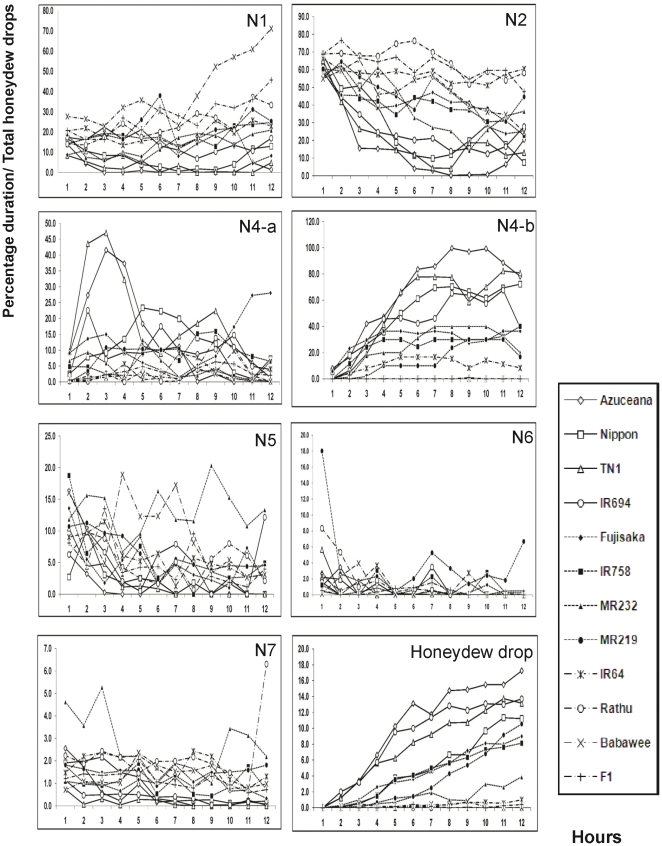
Comparative graph between EPG waveform and honeydew drops.This graphs are based on percentage duration for each waveform types, NP (Non penetration), pathway, N4-a (sieve element salvation), N4-b (phloem ingestion), N5 (xylem ingestion), N6 (derailed of stylet mechanics) and N7 (potential drop) and honeydew drops for 12 rice varieties. Data were recorded from the first time when BPH make a connection with the plant and then stopped after 12 hs.